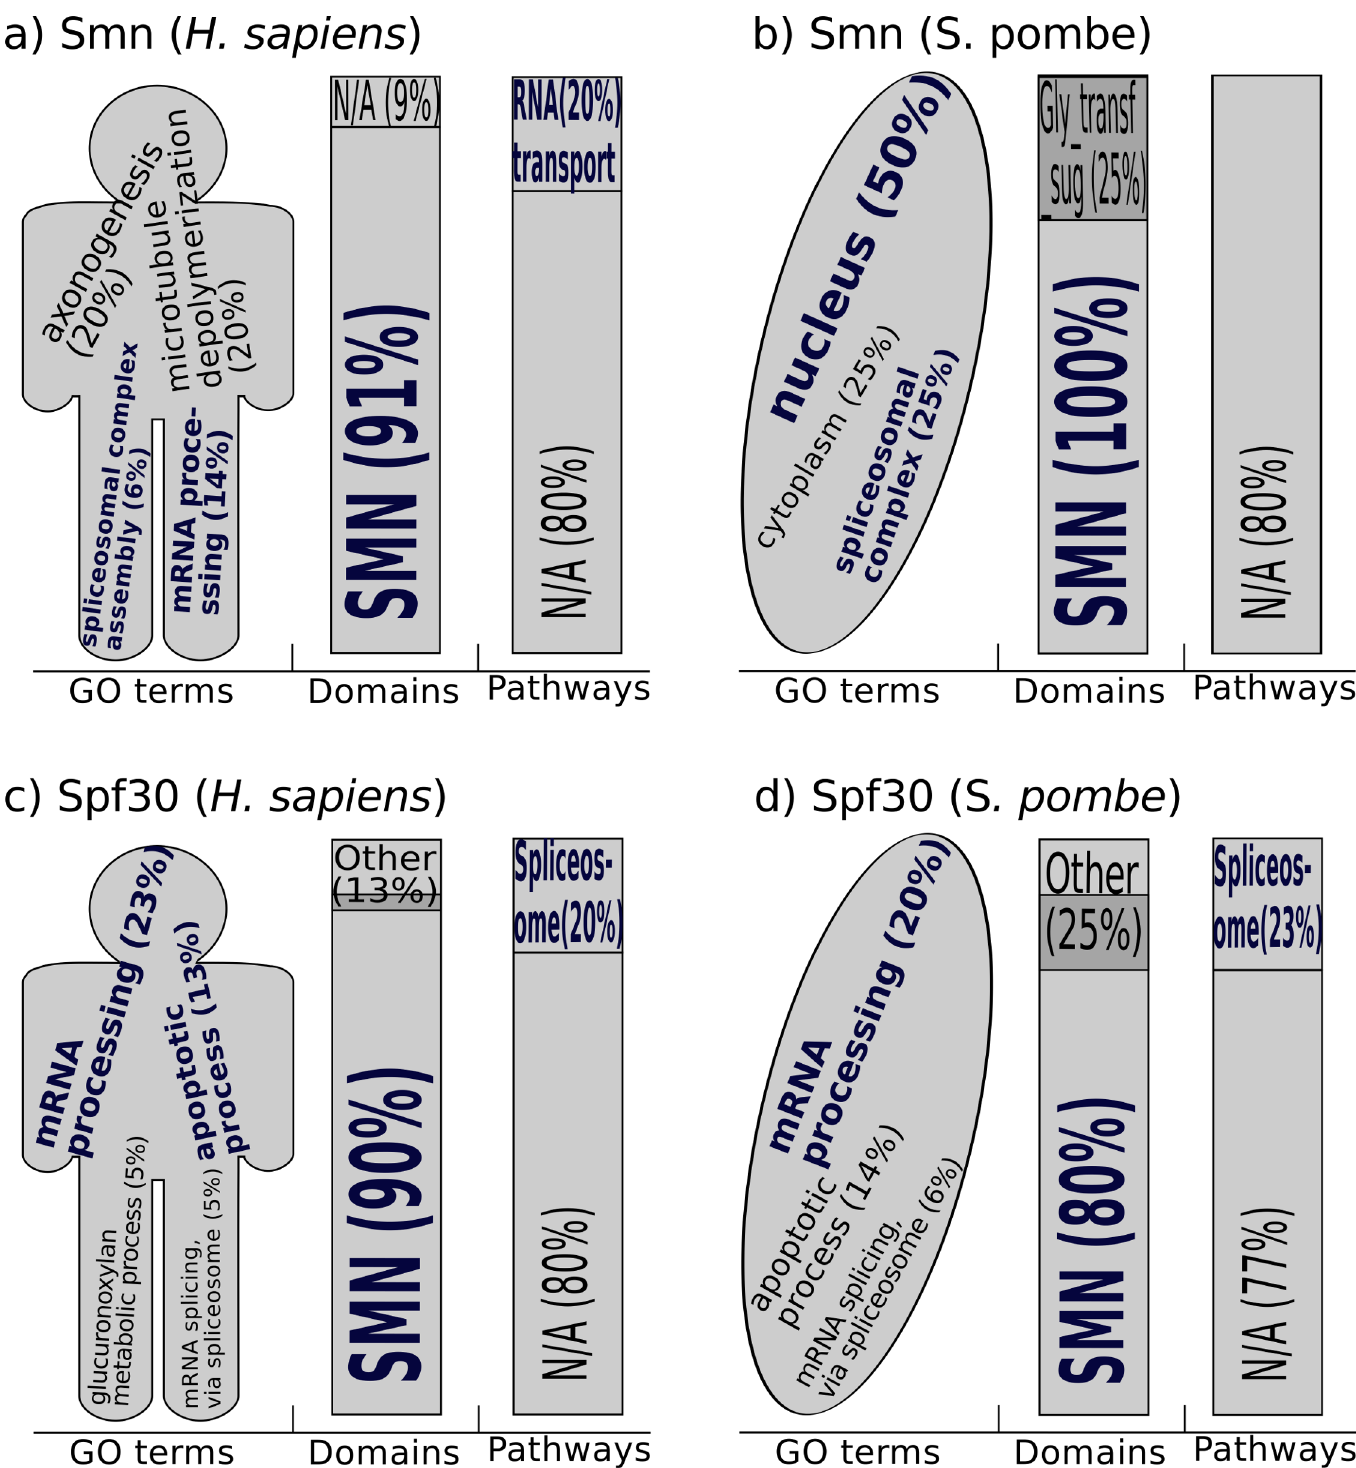
Fig 5. Annotations from the Smn and Spf30 orthologs found by orthoFind. The annotations were extracted from the results of the analyses described in Fig 4 when only one query sequence was used. Terms highlighted in blue color represent known annotations for these proteins. The relative frequency of each annotation reported by the web application in the results is shown within parentheses, and the letter size is correlated with its frequency. Only annotations with frequency higher than 5% have been taken in account, and only GO terms from biological processes have been used, except for S . pombe Smn, where cellular component was used because of the lack of other annotated GO terms. N/A = not available domain or